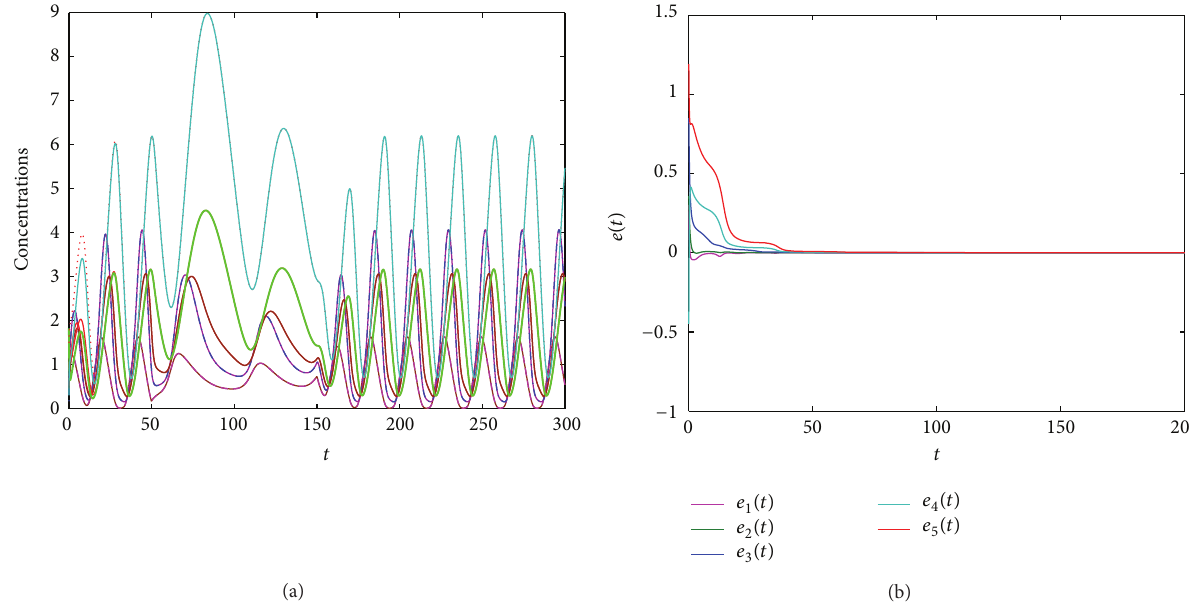
Figure 5: (a) State trajectories of systems (3) and (17) with step input signal 𝑢(𝑡) in (19). (b) The error dynamics between systems (3) and (17). Here 𝑦(𝑡) = (𝑐 1 𝑥 1 (𝑡),𝑐 2 𝑥 2 (𝑡)) 𝑇 , 𝛼 = 2, 𝛽 = 3, 𝑐 1 = 2.2, and 𝑐 2 = 1 .